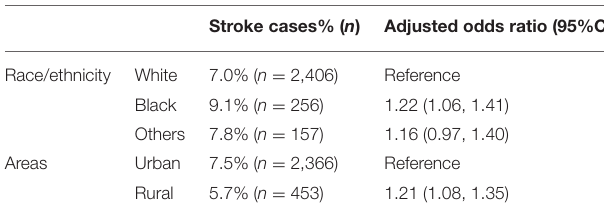
TABLE 1 | Adjusted odds ratios of new AF diagnosis manifesting as stroke across racial/ethnicity groups and between urban and rural